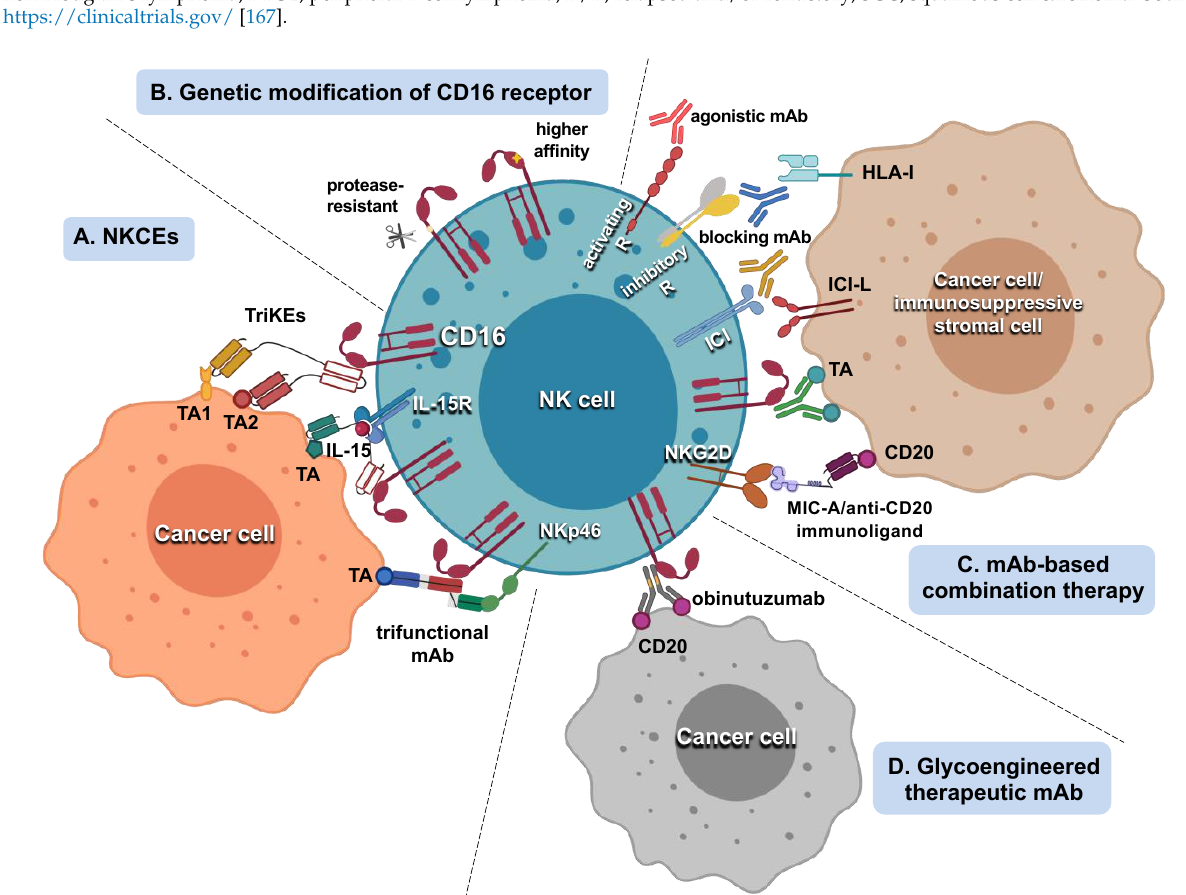
Figure 1. Overview of the main strategies aimed at potentiating therapeutic mAb-mediated CD16 activation of NK cells: ( A ) NK cell killer engagers (NKCEs). Recombinant chimeric molecules, such as trispecific killer engagers (TriKEs), which are composed of three single-chain variable fragments (scFv) recognizing CD16 and two different tumor-associated anti-gens (TA); two scFv fragments, linked to IL-15 moiety; trifunctional mAbs composed of two Fab fragments directed against a TA and NKp46, and a high-affinity Fc region, to target CD16. ( B ) Genetic modifications of CD16 gene to abolish sensitivity to ADAM-17-mediated proteolytic cleavage or to enhance affinity for IgG Fc region. ( C ) Tumor-targeting mAbs can be combined with agonistic mAbs targeting activating receptors; blocking mAbs targeting HLA-I-specific inhibitory receptors or immune checkpoints (ICI); immunoligands targeting a TA and engaging an activating receptor (MIC-A/anti- CD20). ( D ) Anti-CD20 humanized mAb obinutuzumab has been Fc glycoengineered to increase binding affinity for CD16